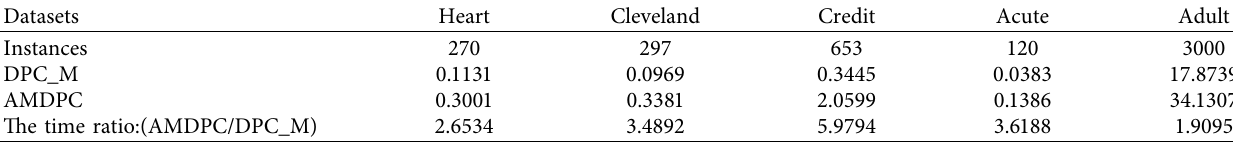
Table 11: Time-complexity comparison between AMDPC and